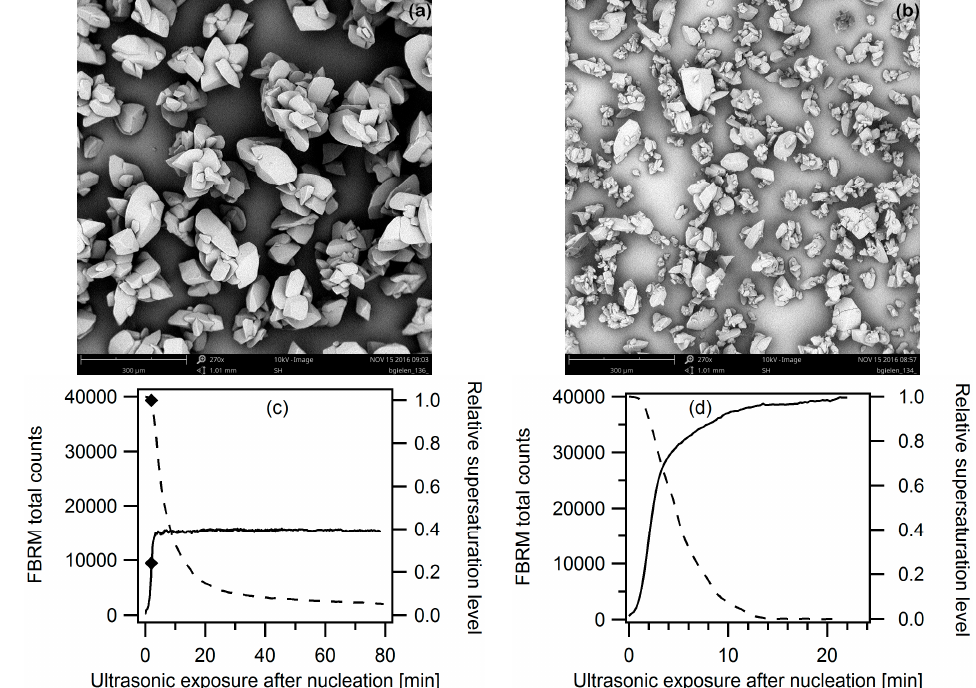
Figure 17 . FBRM, IR and SEM analysis of the crystal morphology obtained after a targeted application of ultrasound during the seeding stage at 57 °C, corresponding to C 0 / C sat = 5.28. The solid lines represent the FBRM data and the dashed lines show the relative supersaturation level. A comparison is made between: ( a , c ) limited exposure time which yields star-shaped crystals; and ( b , d ) the production of mono-crystals after sonication until complete desupersaturation.